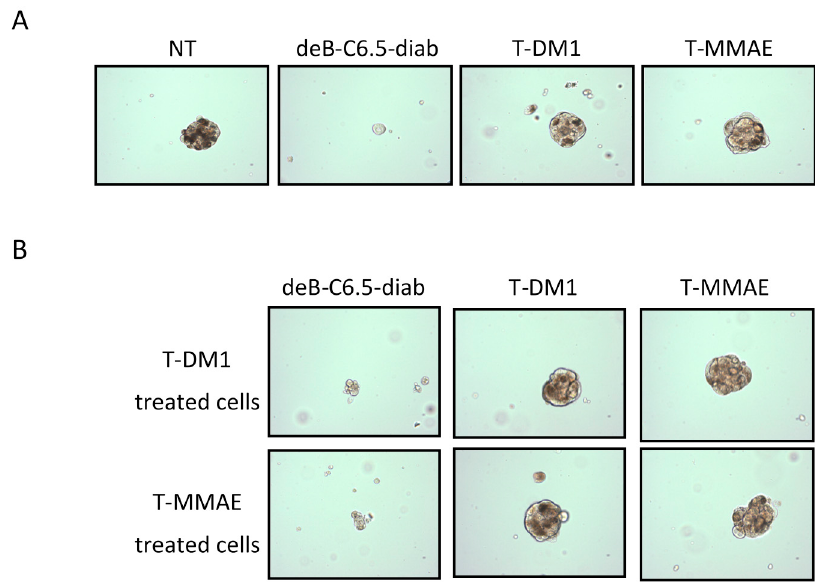
Figure 4. Cytotoxicity of deB-C6.5-diab (blue), T-DM1 (red), T-MMAE (green), and T-deB (purple) against HCC1419 cells surviving T-DM1 ( A ) or T-MMAE ( B ) treatments. Representative examples of two independent experiments.